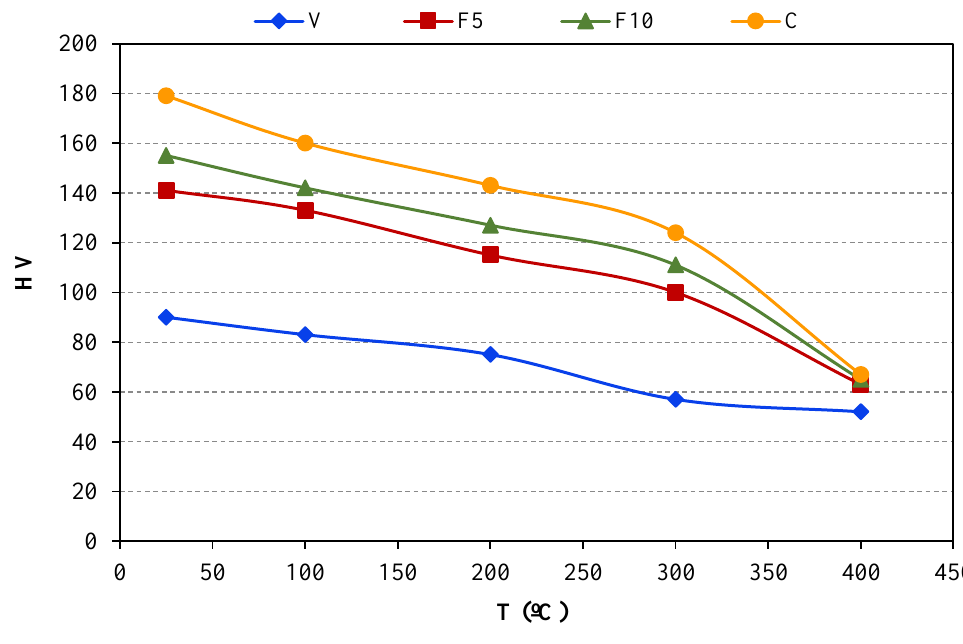
Figure 3. Vickers hardness at high temperature.